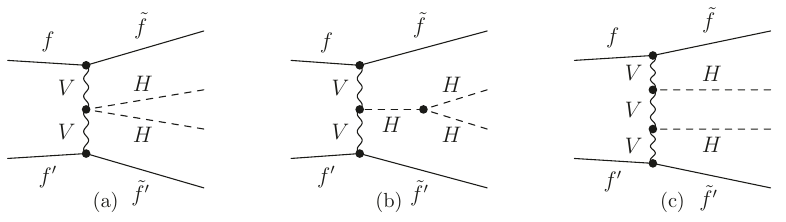
Figure 5 . Representative Feynman diagrams contributing to WBF p ( f ) p ( f 0 ) → HHjj . We consider H → b ¯ b final states, but do not include the decays to the